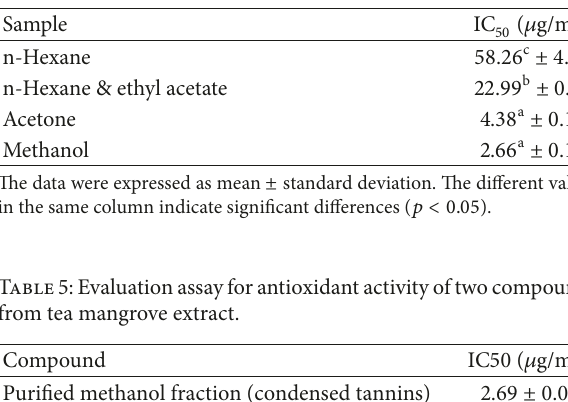
Table 4: Antioxidant activity of the fractions from tea mangrove extract.